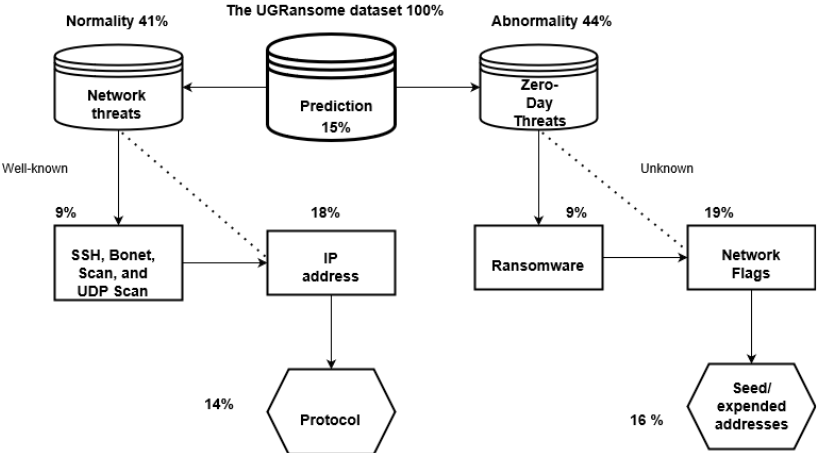
Figure 28. The construction of the UGRansome dataset based on normal and abnormal